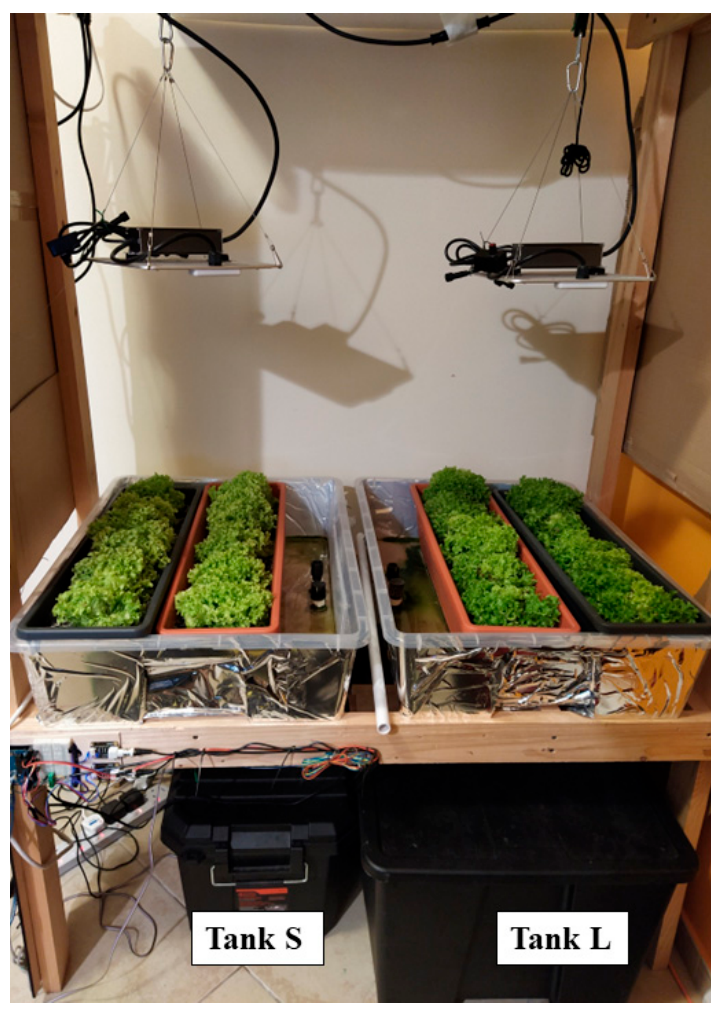
Figure 8. Experimental setup in residential flat. Photo taken in week three. Table 6. Total fresh and dry weight from the 28-day